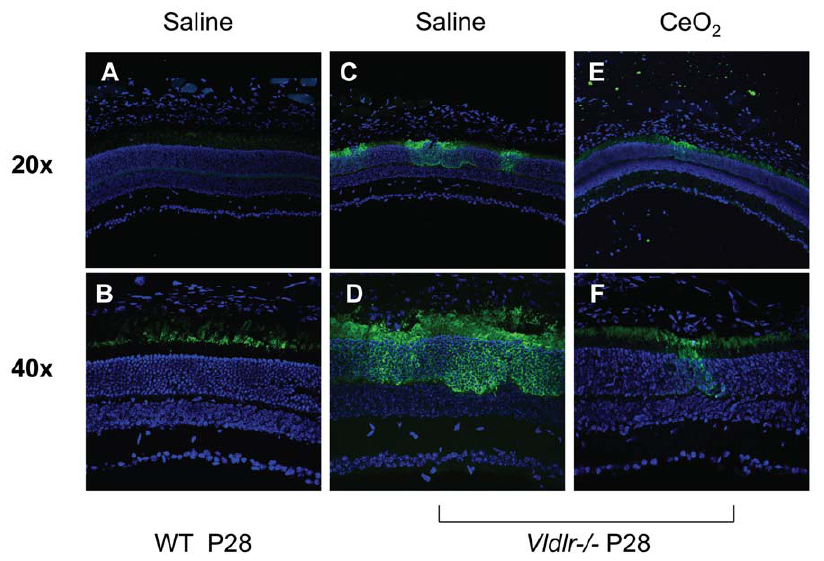
Figure 4. Nanoceria inhibit the ectopic expression of VEGF in the ONL of the Vldlr-/- retina. Photomicrographs of the Vldlr-/- retina showed discontinuous heavy staining of VEGF across the ONL ( C,D ) at P28. The labeling was greatly reduced in the nanoceria injected ( E,F ) Vldlr-/- mice. WT retinas ( A,B ) had low levels of VEGF in the rod outer segments. DAPI (blue) was used to visualize the nuclei.